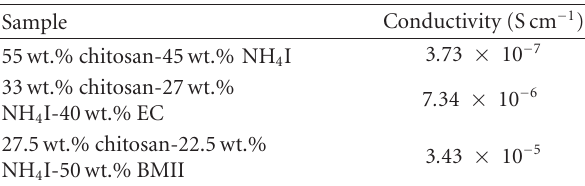
Table 1: Electrolytes composition and conductivity at ambient